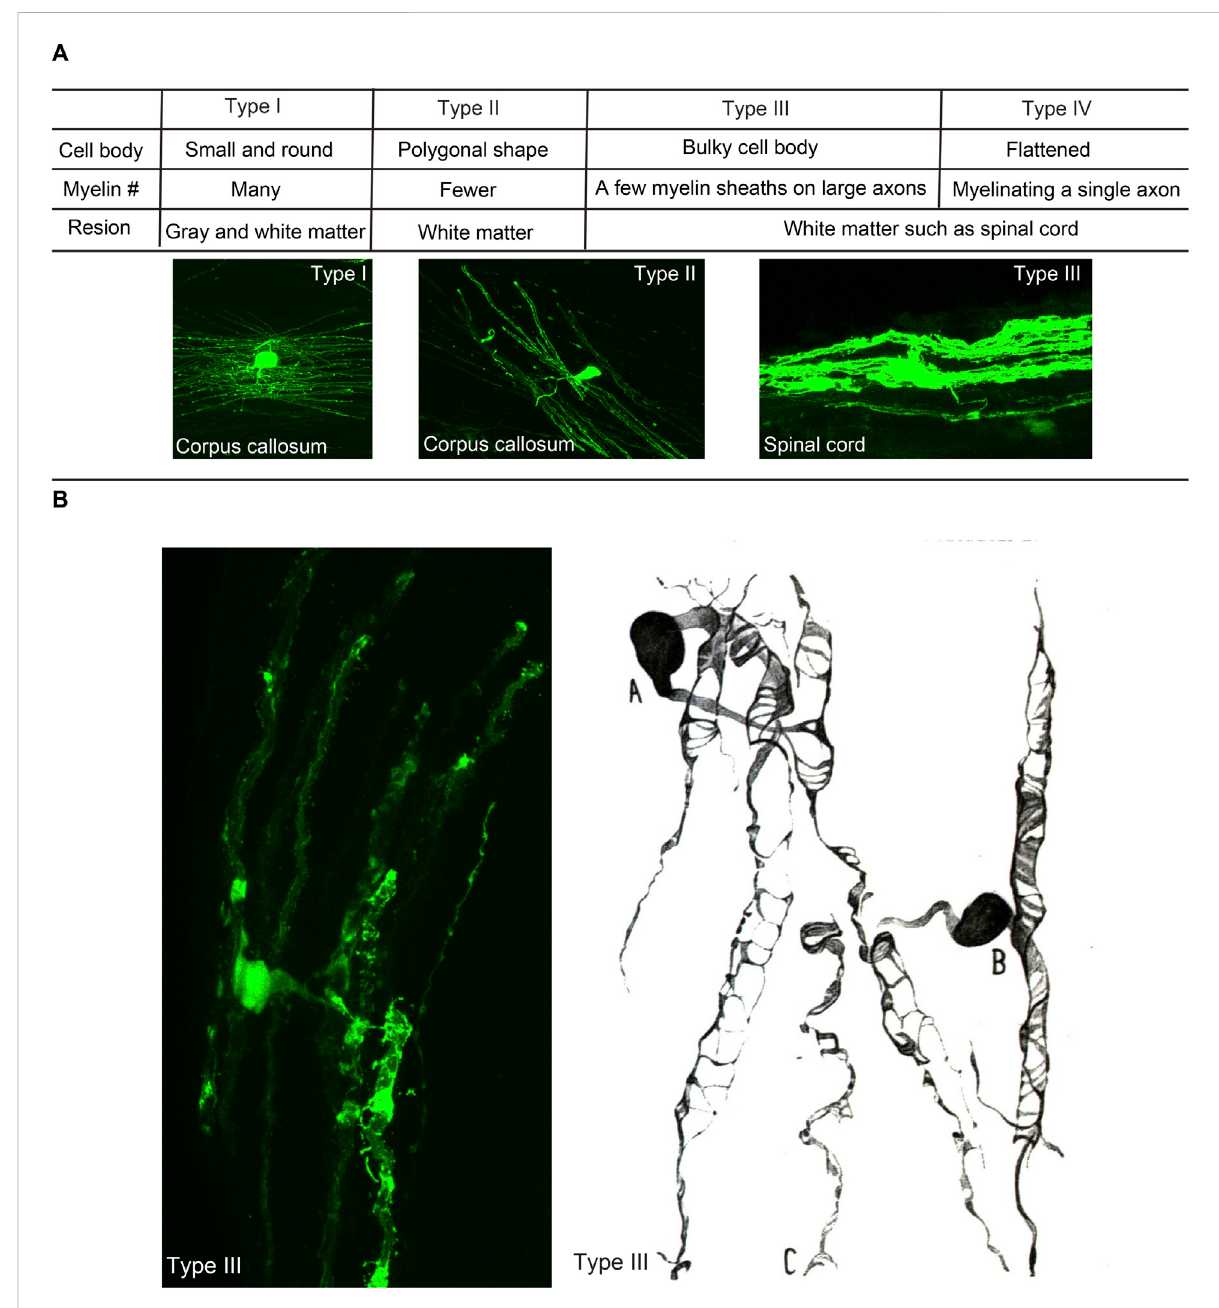
FIGURE 1 Morphological heterogeneity of oligodendrocytes. (A) Characteristics and shapes of different types of oligodendrocytes, following the classi fi cation by Pio del Río Hortega (1928). (B) Type III oligodendrocyte in the mouse spinal cord (Osanai et al., 2017) and that in the cat medulla oblongata described by Rio Hortega